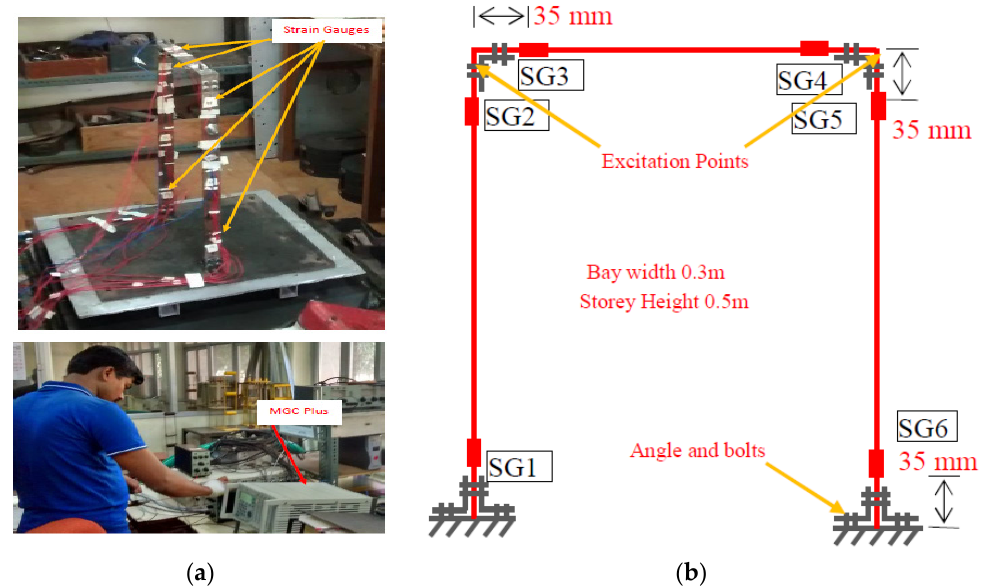
Figure 3. ( a ) Experimental steel planer frame model on the rigid platform and data logger, ( b ) schematic diagram showing the location of sensors and excitation points.